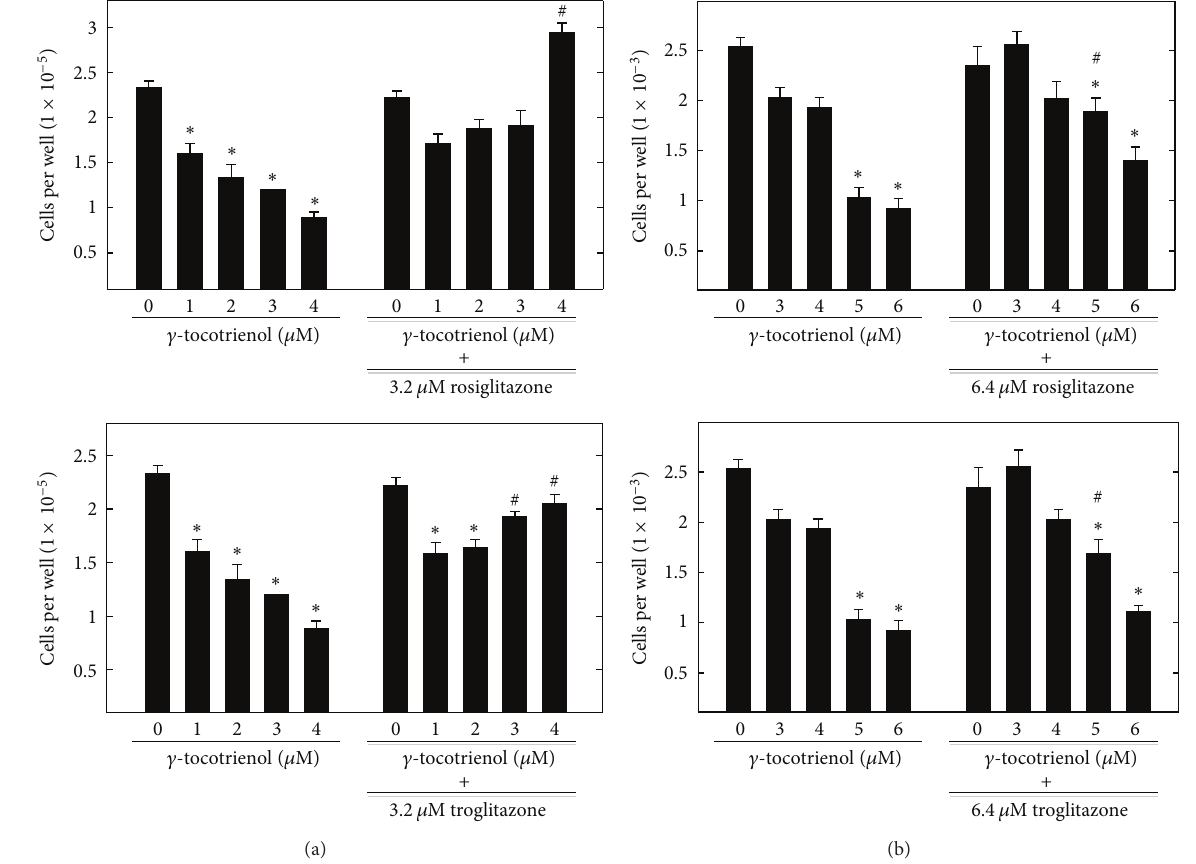
-tocotrienol, PPAR agonist rosiglitazone and troglitazone treatment alone or in combination on growth of (a) MCF-7 and (b) MDA-MB-231 human breast cancer cells. MCF-7 cells were initially plated at a density of (6 wells per group) in 24-well plates (6 wells per group) in 96-well culture plates and exposed to treatment media and (b) MDA-MB-231 were initially plated at a density of 𝛾𝛾 𝛾𝛾 for a 4-day period. Aerwards, viable cell number was determined using MTT colorimetric assay. Vertical bars indicate the mean cell count SEM in each treatment 1×10